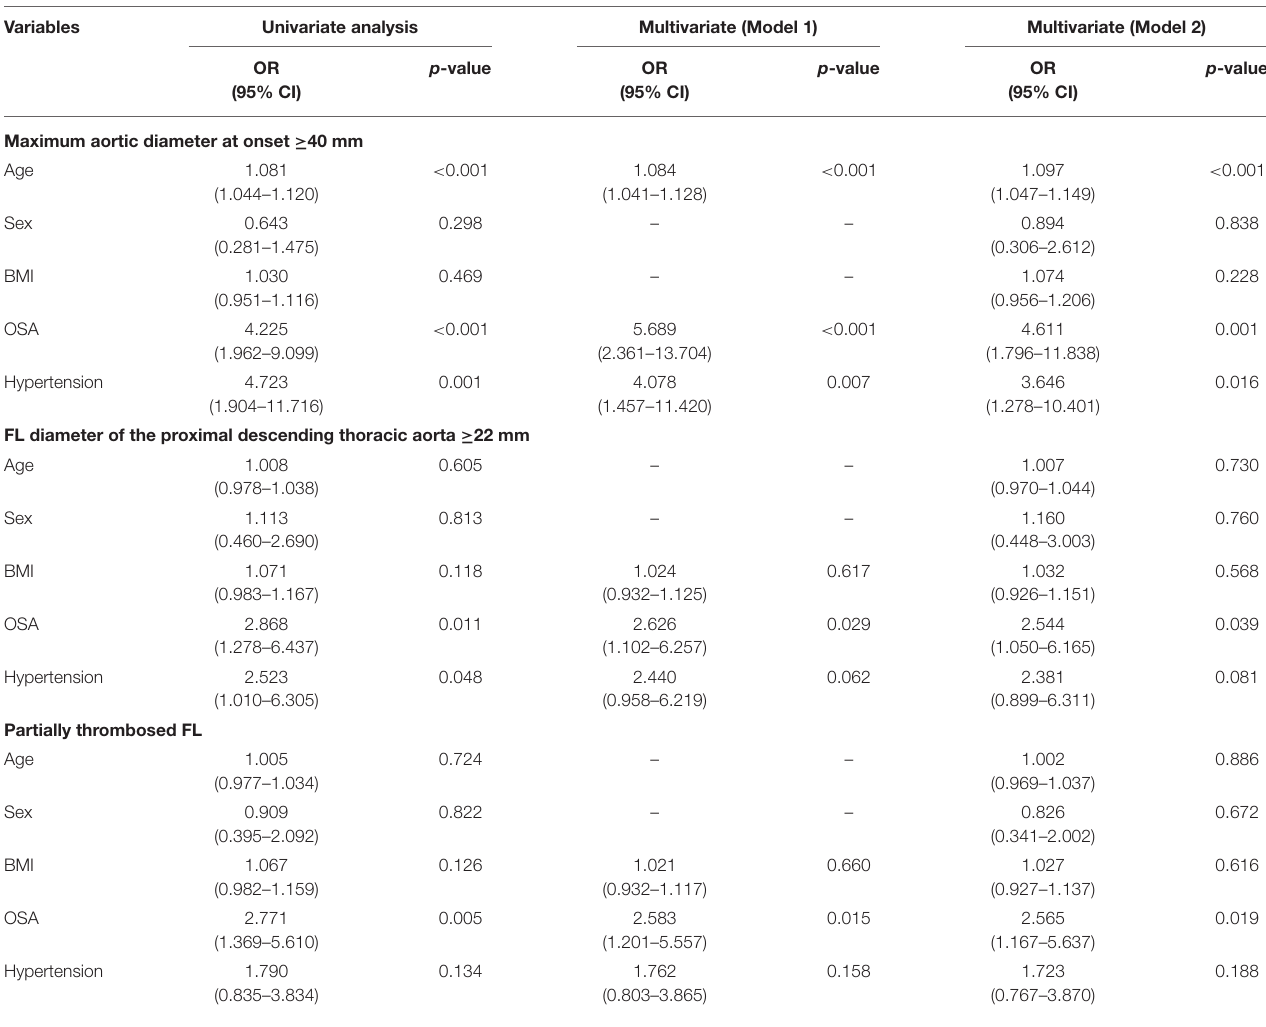
TABLE 3 | Univariate and multivariate logistic analyses of imaging signs related to